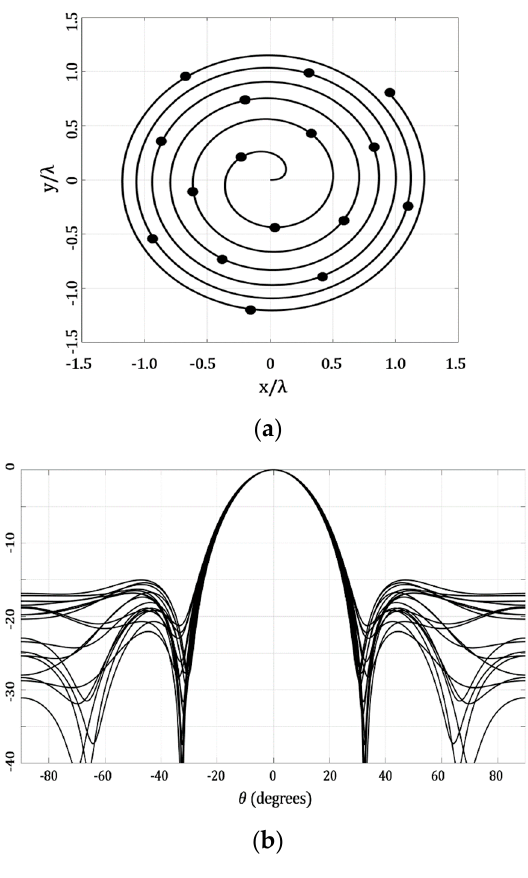
Figure 7. Design case that considers the application of raised cosine for a non-uniform amplitude excitation: ( a ) geometry generated and ( b ) array factor results.